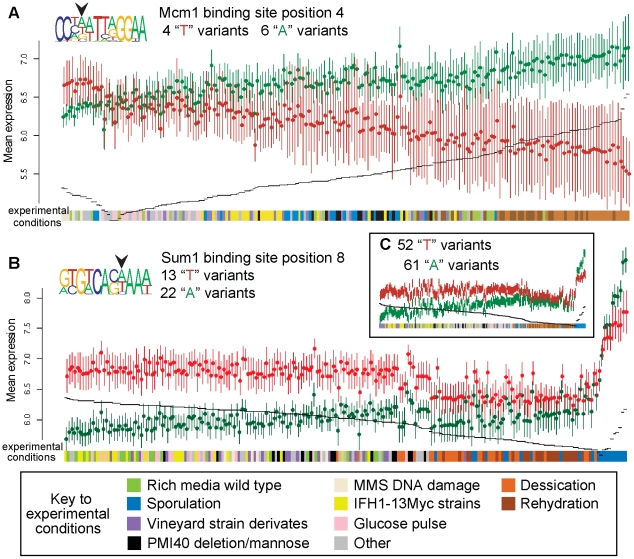
Examples of binding site motif variants (BSMVs) associated with condition-specific gene expression.Mean expression values (Affymetrix; y axis) of genes with each of two BSMVs are plotted on each graph (standard error of mean shown), although more BSMVs may be present at that position. The means are ordered across conditions (x axis) according to the difference in mean expression between the two BSMVs (black dashes). (A) Mcm1, involved in cell-type-specific transcription and pheromone response, has functional variants at position 4 of its binding motif. Genes with “T” at position 4 of the Mcm1 binding site (red) are induced relative to genes with “A” BSMVs (green) after DNA damage with MMS. While undergoing desiccation and rehydration, genes with “A” BSMVs are induced in comparison to genes with “T” BSMVs. (B) Sum1, a regulator of sporulation-specific genes, has functional variants at position 8 of its binding motif. Genes with “T” (red) at position 8 of the Sum1 binding site have higher expression than genes with “A” BSMVs (green) during rich media growth in lab or IFH1 myc-tagged strains or glucose pulse after starvation. In sporulation, genes with “A” BSMVs are expressed higher than genes with “T” BSMVs. (C) The effect of the functional variant at position 8 of Sum1 on target genes remains the same when also considering target genes under more complex regulatory control (multiple primary binding sites).